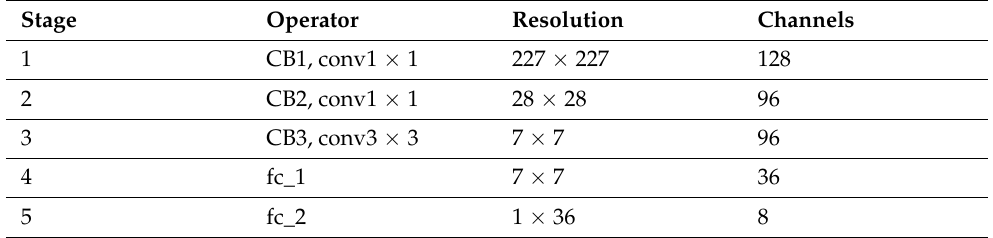
Table 2. Model B2.